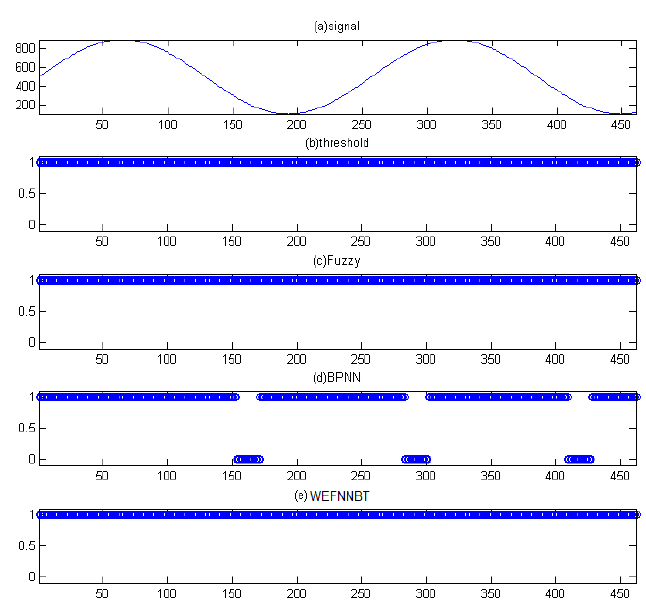
Figure 8. ( a ) Waveform of normal power signal, ( b ) state of protective relay based on identification with threshold method (TM) for normal power signal, ( c ) state of protective relay based on identification with fuzzy analysis (FA) for normal power signal, ( d ) state of protective relay based on identification with back-propagation neural network (BPNN) for normal power signal, and ( e ) state of protective relay based on identification with proposed WEFNNBT for normal power signal.